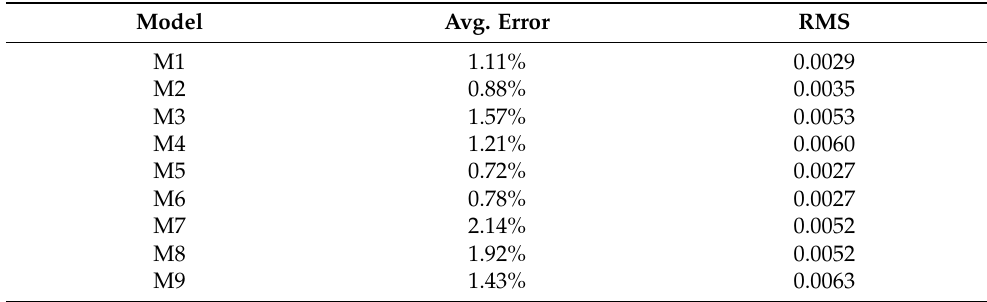
Table 2. Average error and standard deviation between simulation and experimental values for M1–M9 coiled